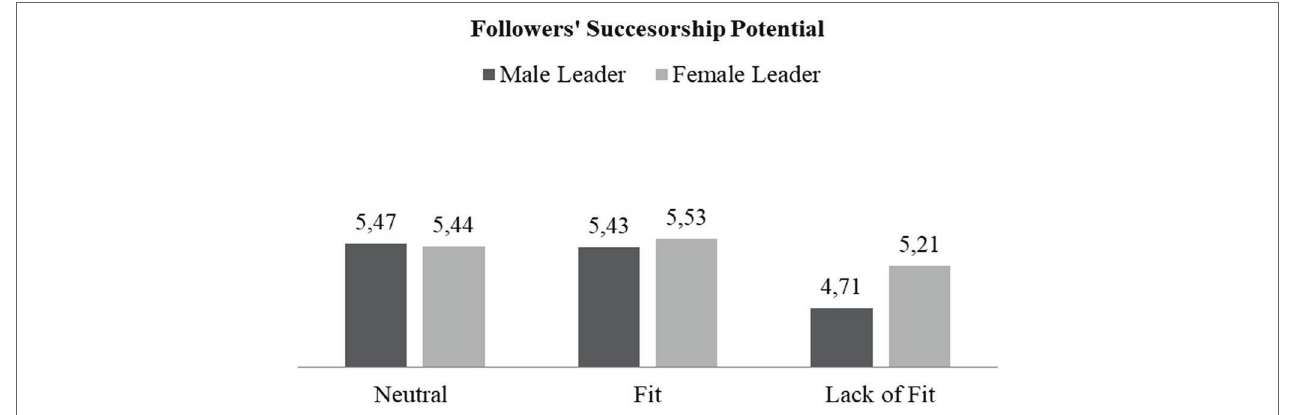
FIGURE 4 | Interactive relationship of follower fit and leader gender with leaders’ assessment of followers’ successorship potential (study